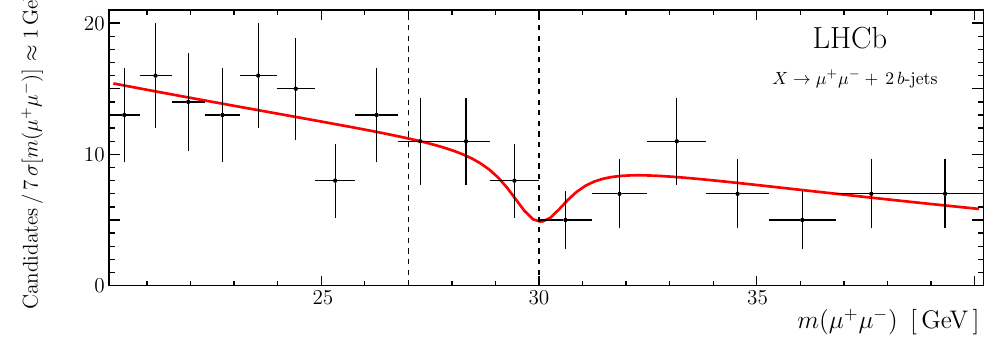
Figure 5 . Fit to the m ( (cid:22) + (cid:22) (cid:0) ) spectrum in events with at least two b -tagged jets. The 27 < m ( X ) < 30 GeV search region is marked by the vertical dashed